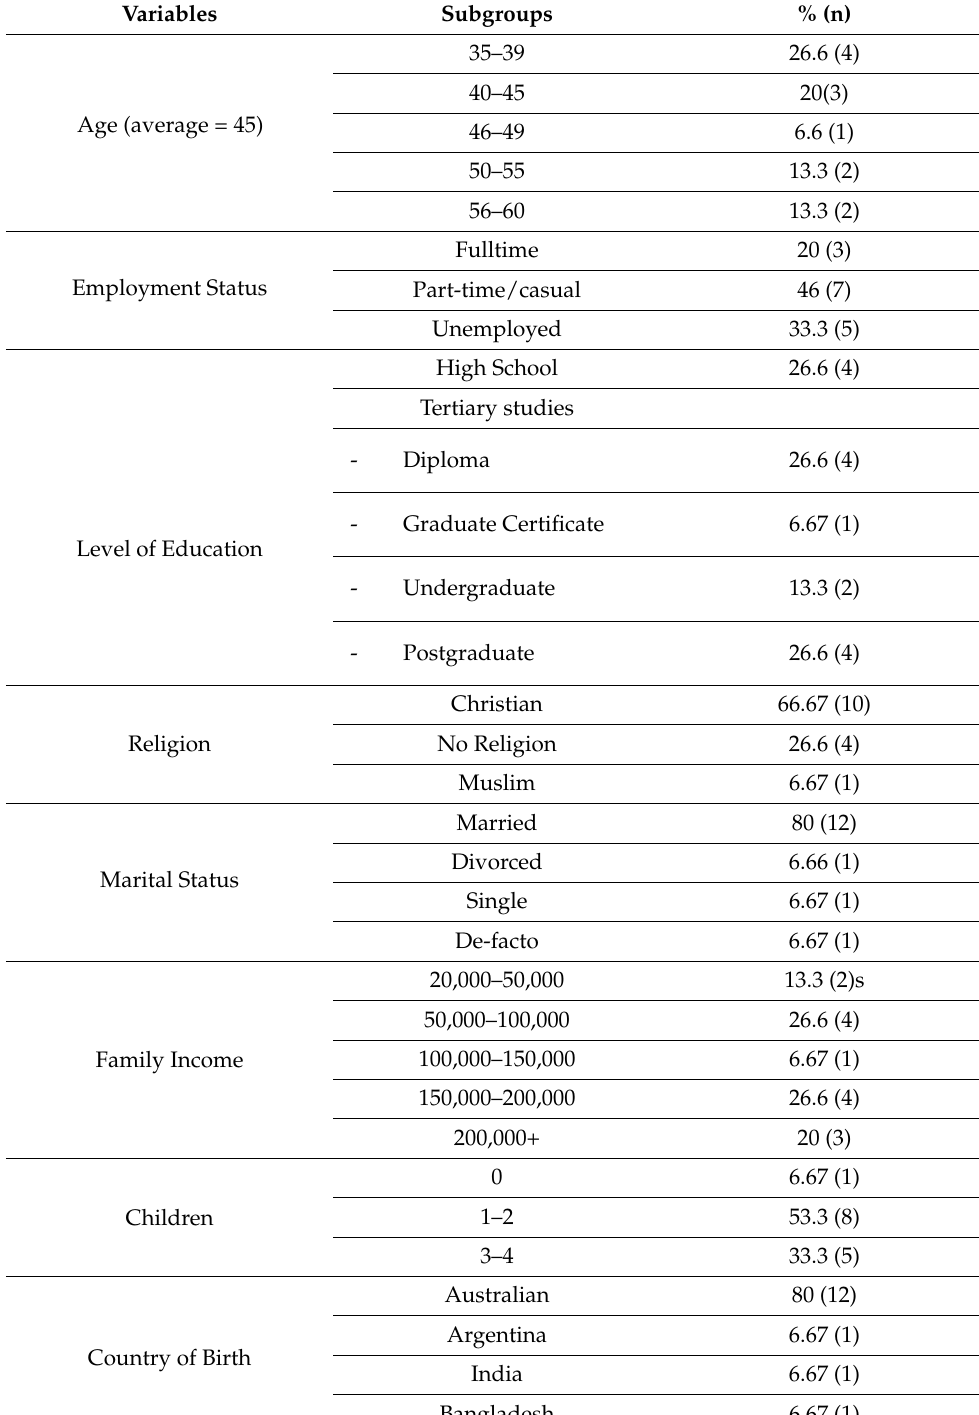
Table 1. Sociodemographic